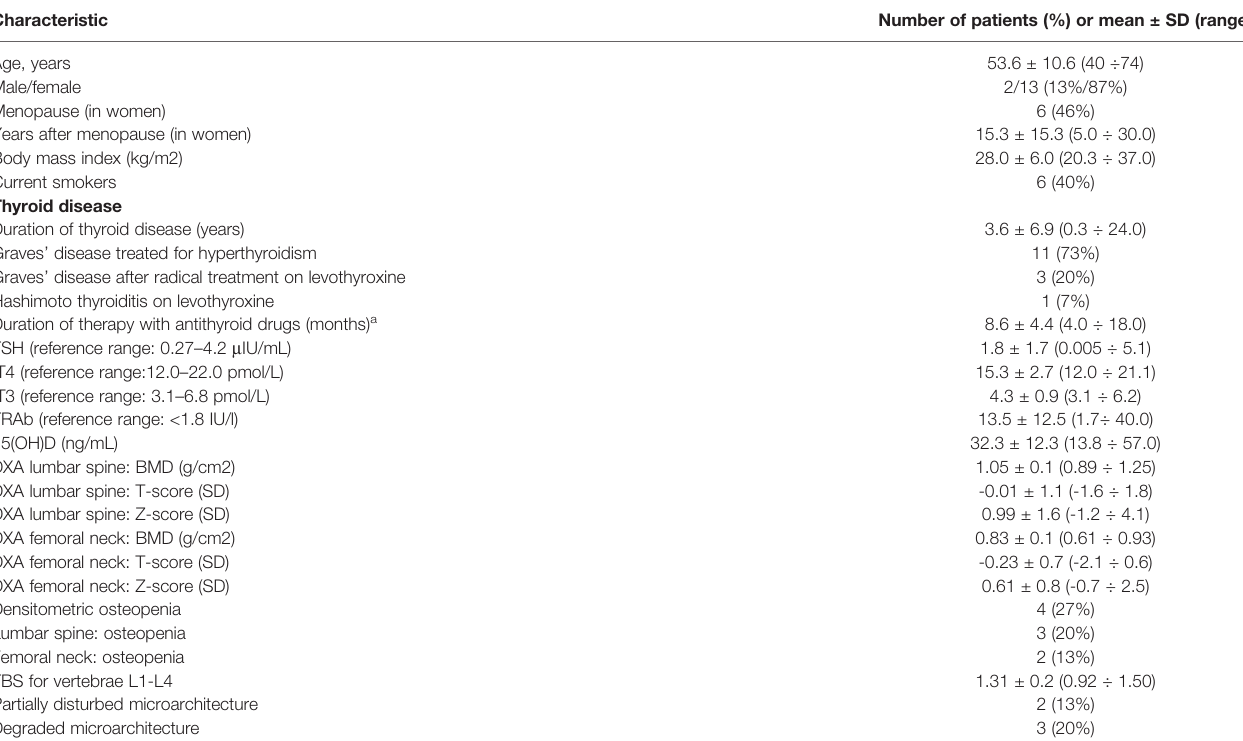
TABLE 1 | Baseline characteristics of patients (n = 15).